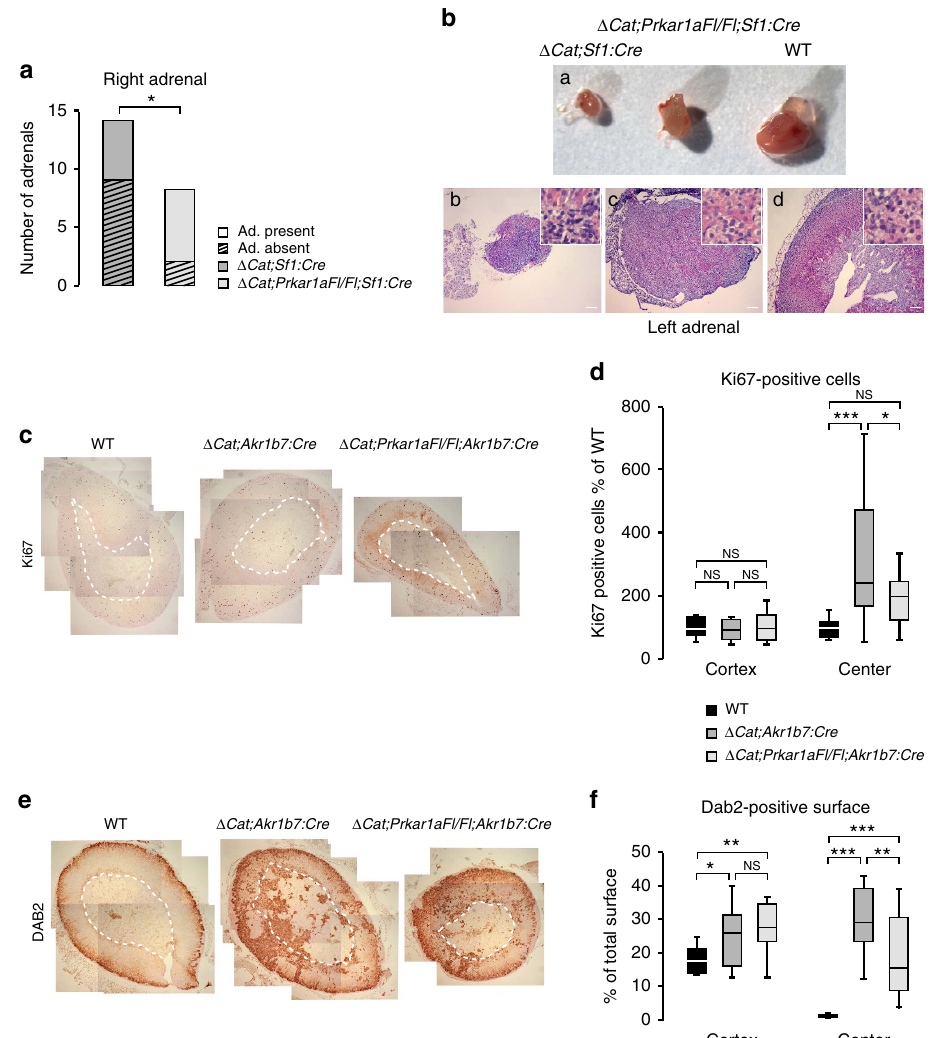
Figure 5 | Constitutive PKA signalling counteracts constitutive WNT signalling. ( a , b ) Constitutive PKA activation partially rescues WNT-induced developmental phenotypes. ( a ) Constitutive activation of b -catenin with Sf1:Cre driver is associated with right adrenal gland aplasia in 9 out of 14 animals (left bar). Genetic ablation of Prkar1a significantly rescues this phenotype (aplasia in two out of eight animals, right bar), P ¼ 0.0416 in N-1 two proportion test. ( b ) Left adrenal size (a) and histological features are partially restored by genetic ablation of Prkar1a in the context of Sf-1:Cre mediated constitutive activation of b -catenin (c versus b). Wild-type adrenal is shown in d. ( c , d ) Constitutive PKA activation inhibits WNT-induced proliferation. ( c ) Ki67 expression was analysed by immunohistochemistry in wild-type, constitutive active b -catenin mutants ( D Cat;Akr1b7:Cre ) and constitutive active b -catenin mutants in the context of Prkar1a genetic ablation ( D Cat;Prkar1aFl/Fl;Akr1b7:Cre ). ( d ) Ki67 positive cells were separately counted in the adrenal cortex and central adrenal region of 12–14 animals of each genotype. Numbers of positive cells are represented as a percentage of positive cells in each wild-type compartment. ( e , f ) Constitutive PKA activation inhibits WNT-induced ectopic ZG differentiation. ( e ) Expression of the ZG marker DAB2 (see Supplementary Fig. 6B) was analysed by immunohistochemistry in the same genotypes as in c . ( f ) DAB2 stained areas were measured separately in the adrenal cortex and central adrenal region of 10–15 animals of each genotype. Stained areas are expressed as a percentage of total adrenal surfaces. Statistical analyses in d , f were conducted by one-way ANOVA followed by Tukey’s post hoc test * P o 0.05; ** P o 0.005; *** P o 0.0005; NS, not significant. Scale bars, 100 m m. Dashed lines delimit cortex from central adrenal area (medulla and ectopic glomerulosa histology (Fig. 6b, b–d versus a) and a significant increase in Ki67 in immunohistochemistry (Fig. 6g, b versus a). These data labelling index (ANOVA, Fig. 6c,d). Acceleration of tumour showed that reduced PKA activity could favour malignant development in response to Prkaca heterozygous ablation was WNT-induced further confirmed by a significant increase in VegfA and a decrease in Connexin a 43 expression, two hallmarks of adrenal malignancy (ANOVA, Fig. 6e). The correlation between decreased PKA activity and increased WNT signalling, was shown by a significant increase in Axin2 and Lef1 mRNA accu- mulation in D Cat;Prkaca þ / (cid:2) ;Akr1b7:Cre mice, compared with D Cat;Akr1b7:Cre mice (ANOVA, Fig. 6f). This was further con- Fig. 6h). To establish a link with WNT signalling, we determined firmed by a marked increase in the number of LEF1-labelled cells